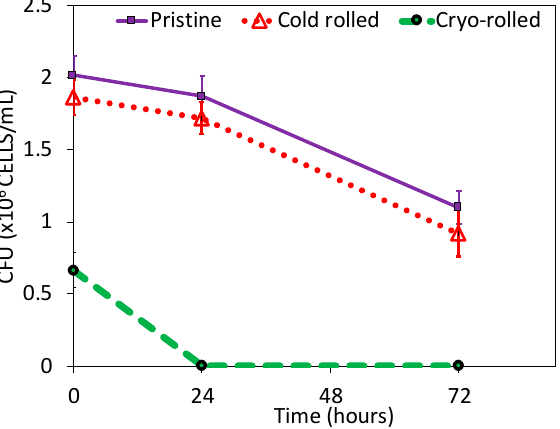
Figure 2. Viability of S. aureus retrieved from copper coupons: Agar plate pictures for 0, 24 and 72 h.